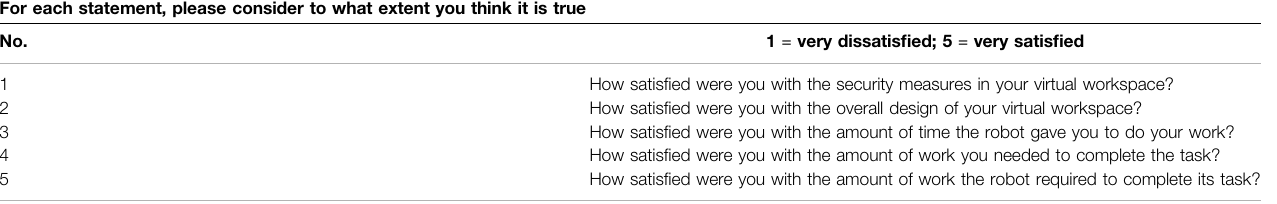
TABLE 1 | Workplace safety is measured by the items derived from the physical work environment satisfaction questionnaire by Carlopio (1996). For each statement, please consider to what extent you think it is true No.